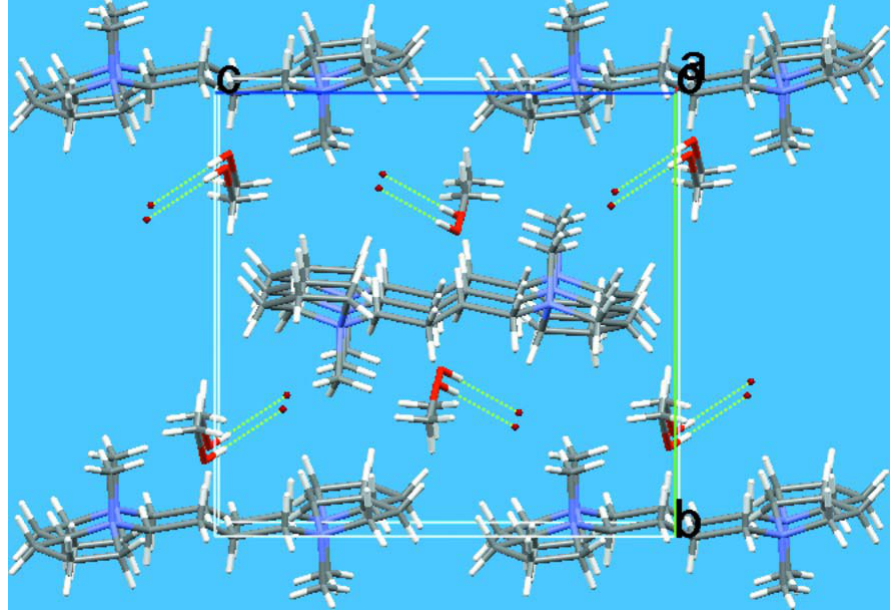
Figure 2 The molecular packing of (I) with hydrogen bonds drawn as dashed